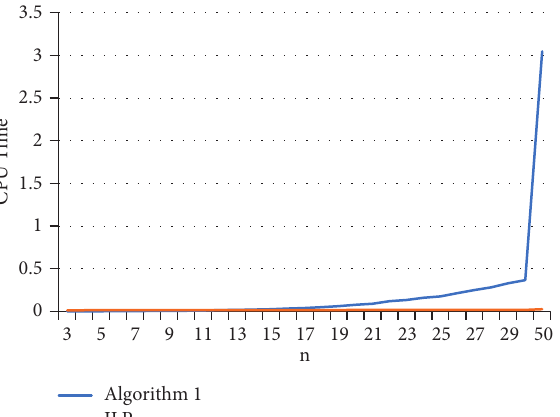
Figure 5: Comparison between standard radio mean square number, algorithm, and integer linear programming for the upper bound of radio mean square number for the path graph according to CPU